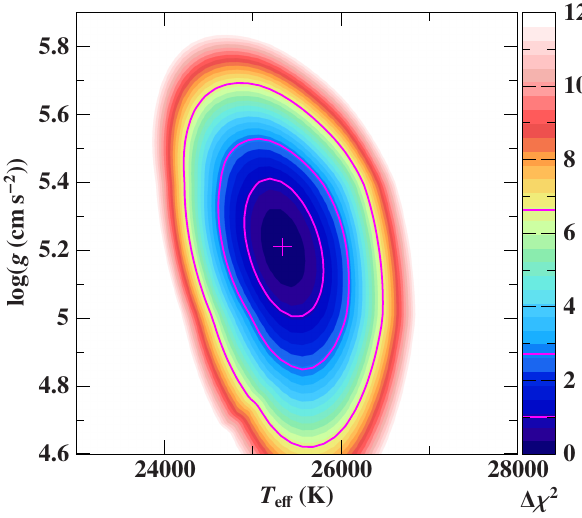
Figure 8. HD205805: Confidence map for the fit shown in Figure 6. The contour lines refer to single parameter uncertainties of 68%, 90% and 99%, respectively. Single parameter 1 σ uncertainties are ∆ T eff =400 K, ∆ log g = 0.2 dex. Table 1. Results of the analyses of the SED (see Figure 7) of PG0749+658.